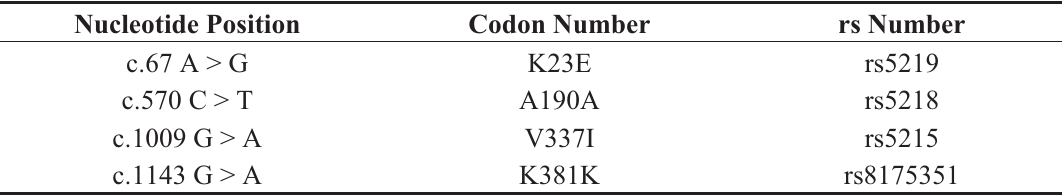
Table 3. Coding variants for KCNJ11 gene (the presence of an rs number represents a change that has been reported in the literature